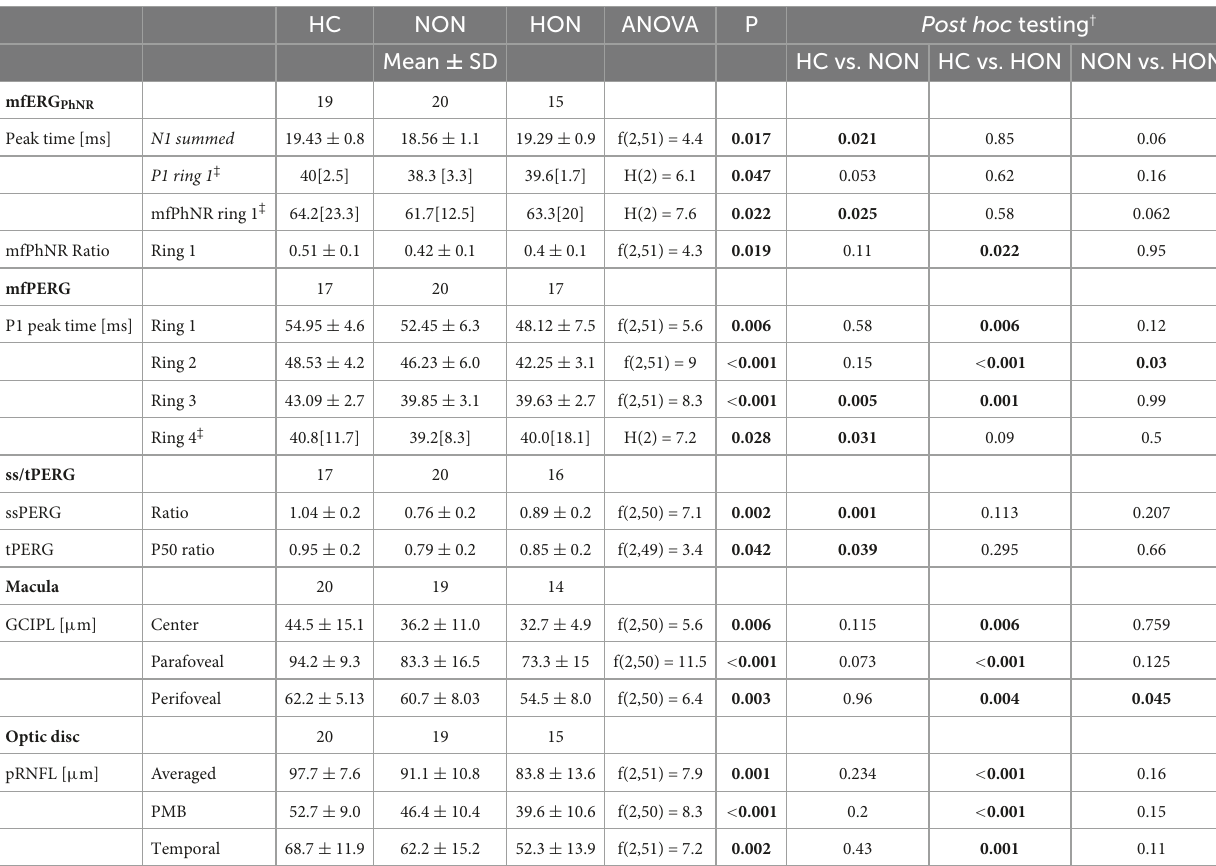
TABLE 3 Functional and structural measures.